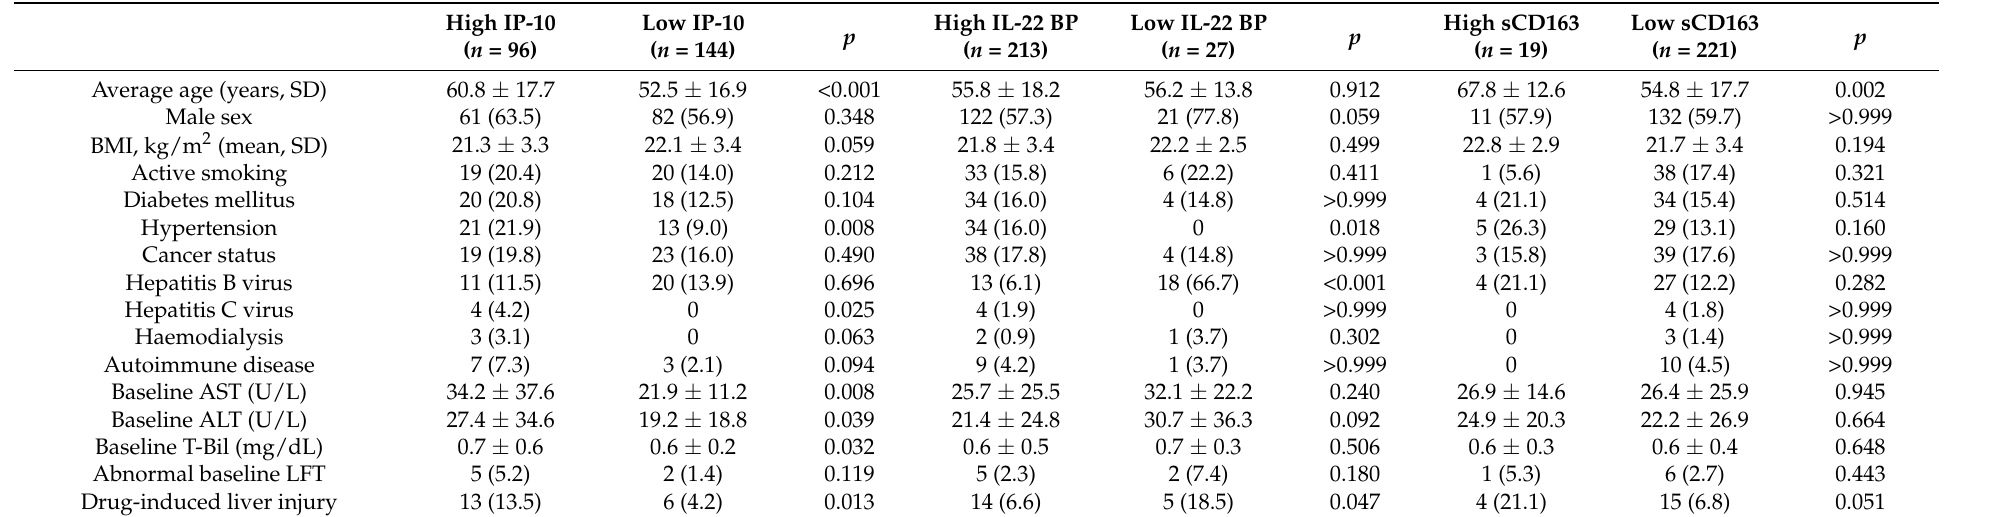
Table 4. Patient characteristics, stratified by IP-10, IL-22 BP, and sCD163